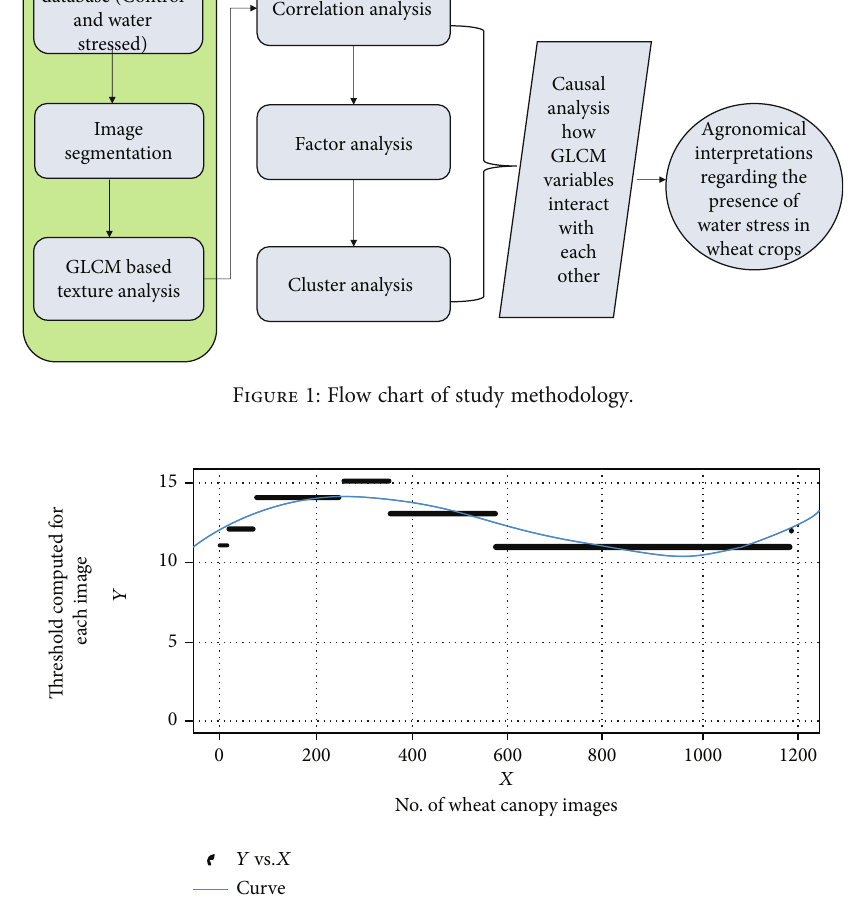
Figure 2: Output of curve fi tting mathematical